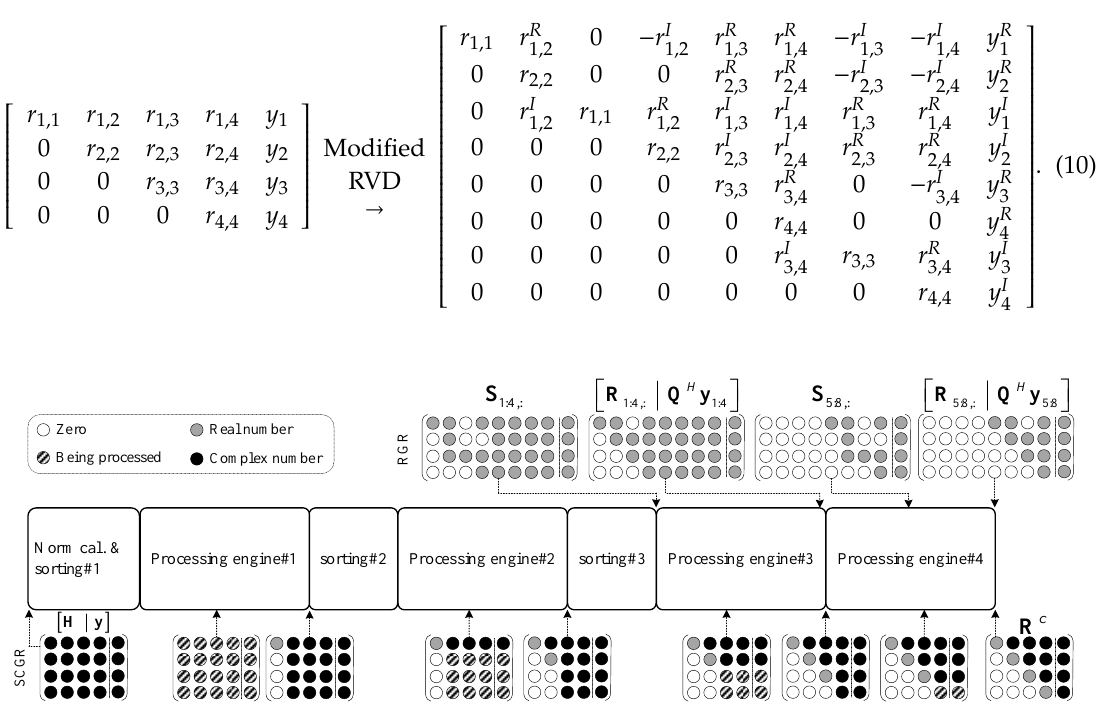
Figure 3. Dataflow diagram of the proposed sorted QR decomposition (SQRD) hardware architecture for 4 × 4 multiple-input multiple-output (MIMO) systems.